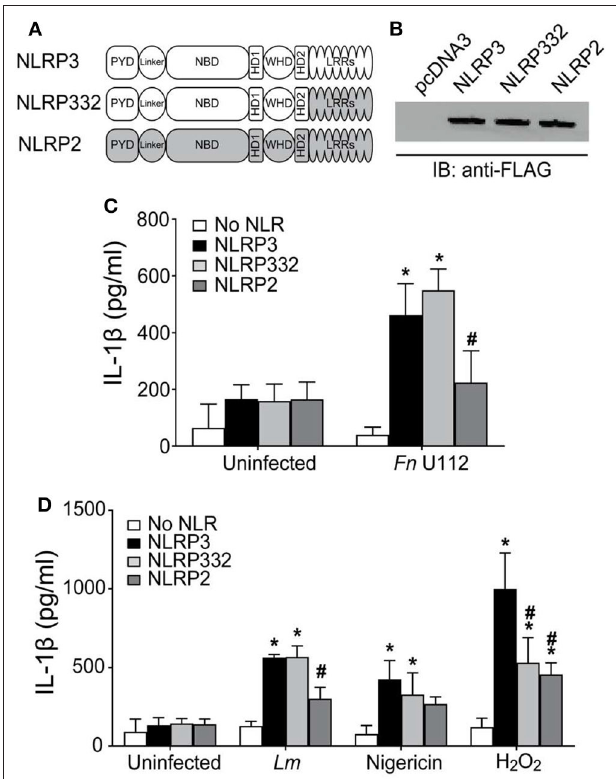
FIGURE 1 | The LRRs of NLRP3 are dispensable for inflammasome activation. (A) Schematic representation of the LRR domain substitution construct. (B) Representative western blot of FLAG-tagged NLRs from HEK293T cell lysate. 10 µ g total protein was loaded in each well. (C,D) IL-1 β response of HEK293T cells expressing ASC, pro-Caspase-1, pro-IL-1 β , and NLRP3, NLRP2, or the LRR domain substitution chimera NLRP332. (C) At 4-h post-transfection, cells were infected with Fn U112 (MOI 100). (D) 18–20h post-transfection, cells were infected with Listeria monocytogenes (Lm) (MOI 20; 6h) or treated with 100 µ M H 2 O 2 (1h) or 5 µ M nigericin (2h). IL-1 β in culture supernatant was measured by ELISA. Data represent means ± SEM for a minimum of three independent experiments. * p < 0.0001 for comparison with respective untreated controls; # p < 0.0001, two-way ANOVA followed by Tukey (*) and Sidak’s ( # ) multiple comparison